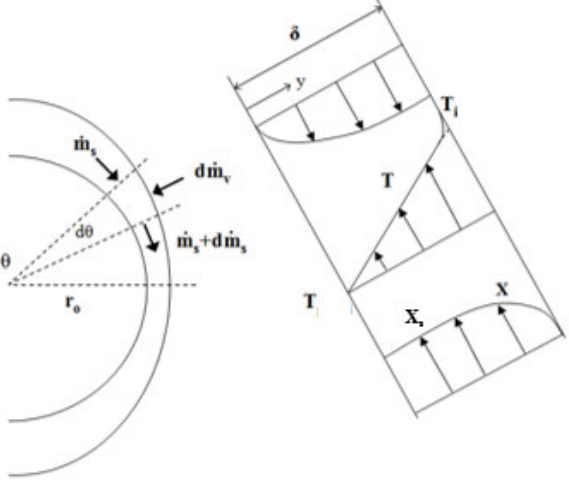
Figure 4. Control volume used in heat and mass transfer balances in the falling ‐ film [9].